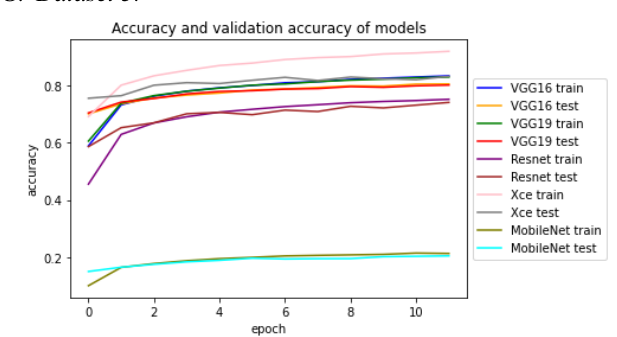
FIGURE X. ACCURACY AND VALIDATION ACCURACY OF MODELS DATASET 1. Figure X represent how accuracy (train) and